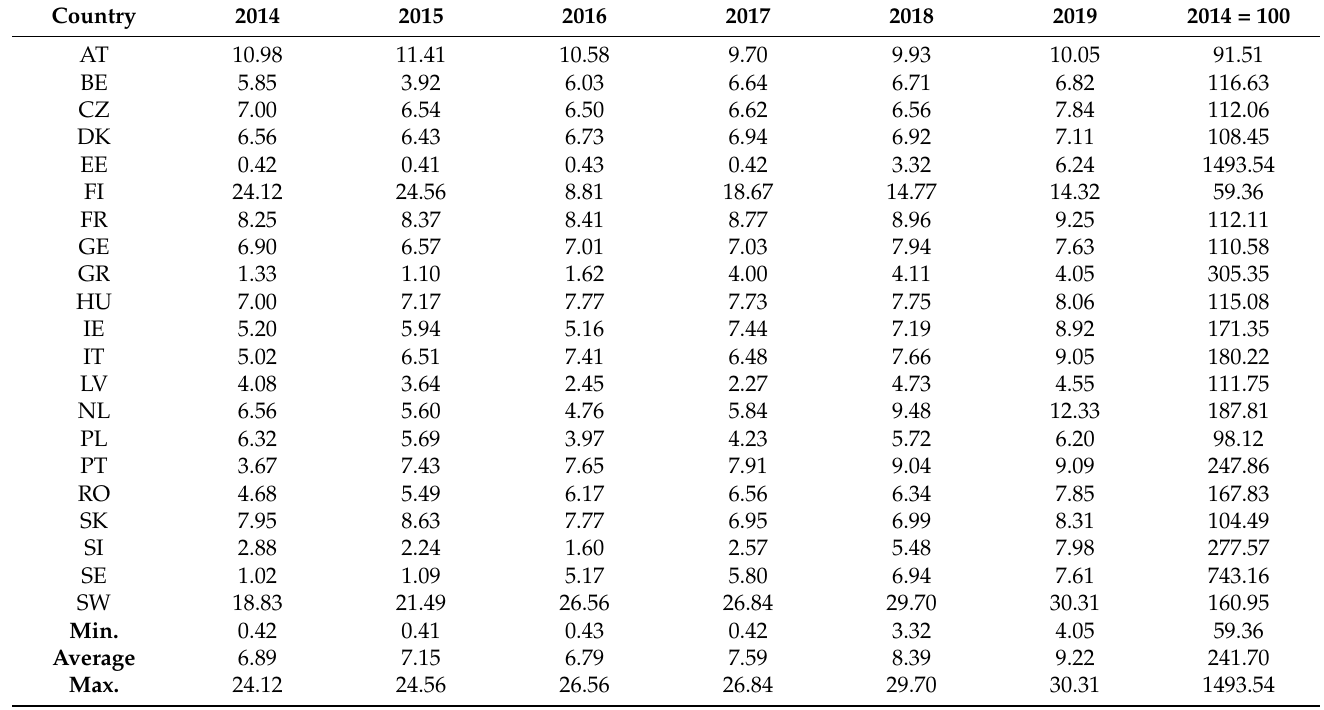
Table 2. Changes in the use of renewable energy sources in transport in selected EU countries in the years